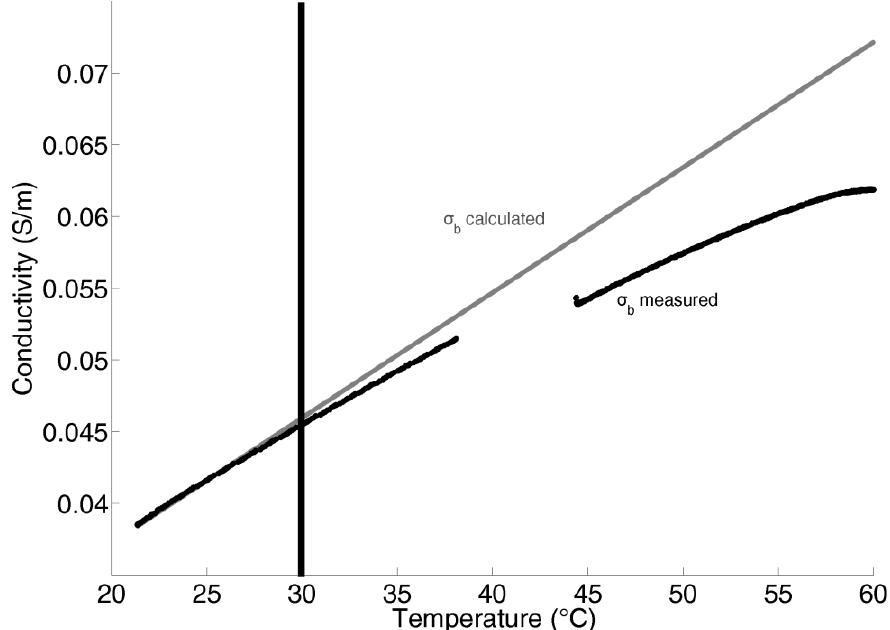
Figure 9. The calculated bulk electrical conductivity (Equation (7)) is not coherent with the measured conductivity due to chemical reactions in the sample (modified after [112]). The missing data correspond to a bad electrical contact on one electrode of the